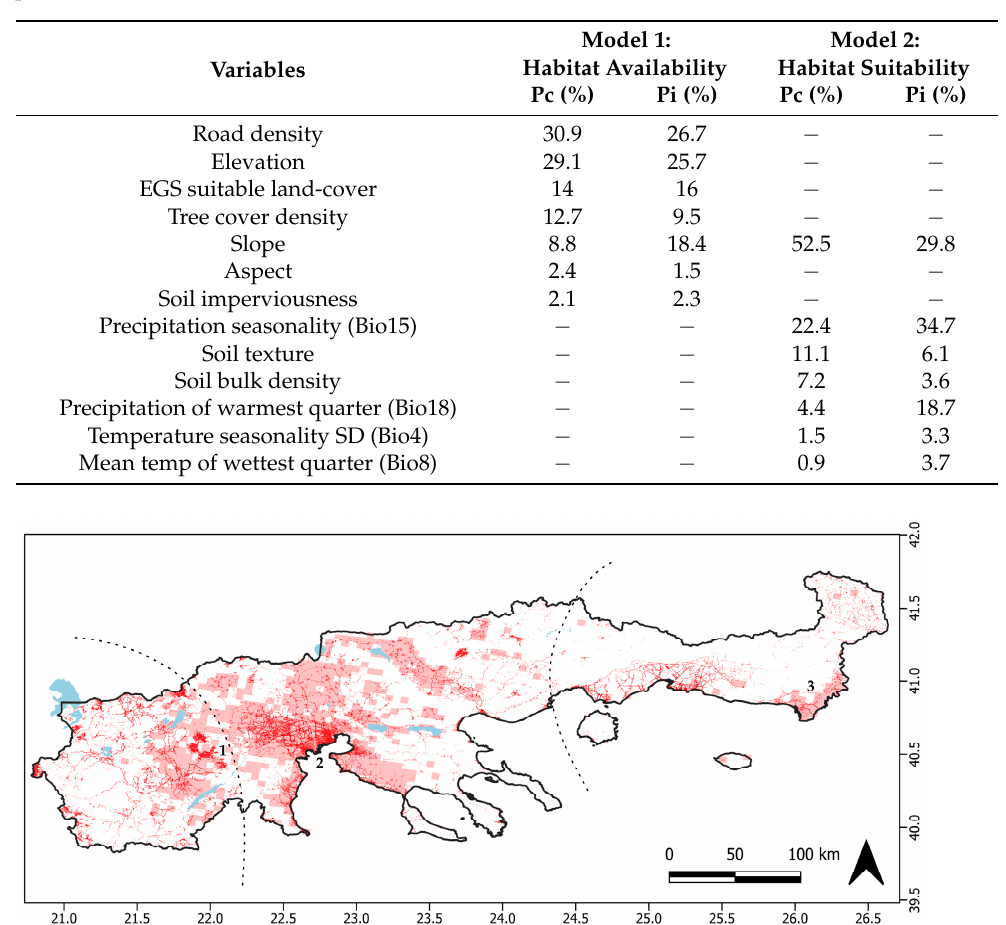
Table 2. Percentage contribution (Pc) and permutation importance (Pi) values of variables used to predict the distribution of available (model 1) and suitable habitats (model 2) of Spermophilus citellus.